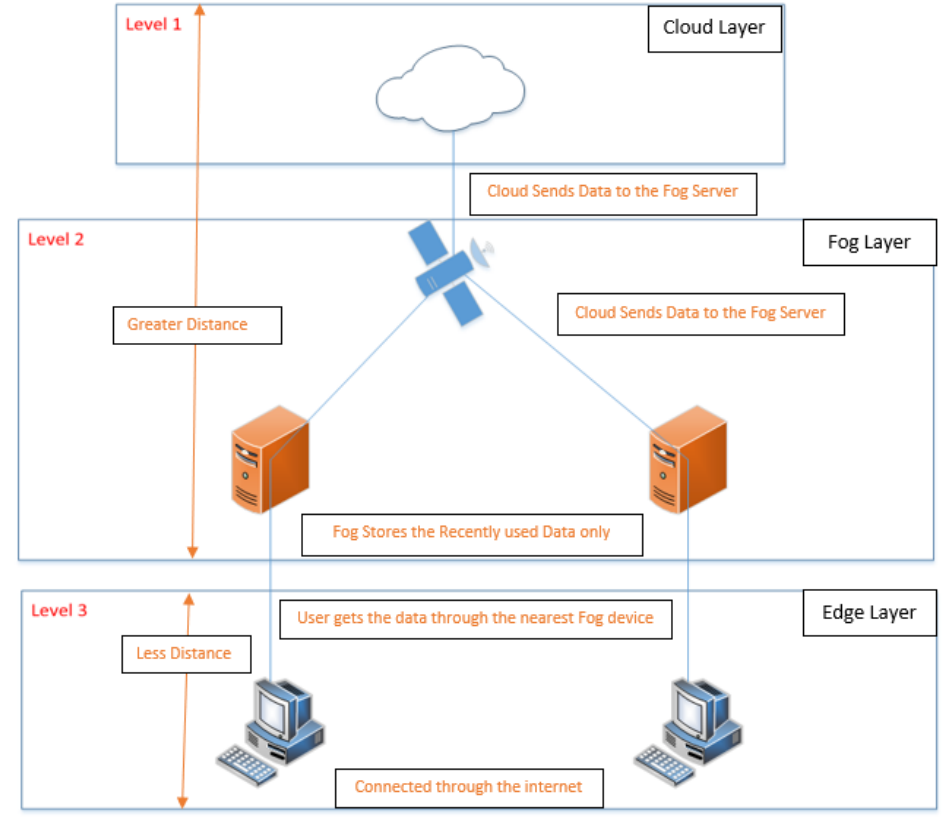
Figure 3. Fog Computing Architecture.